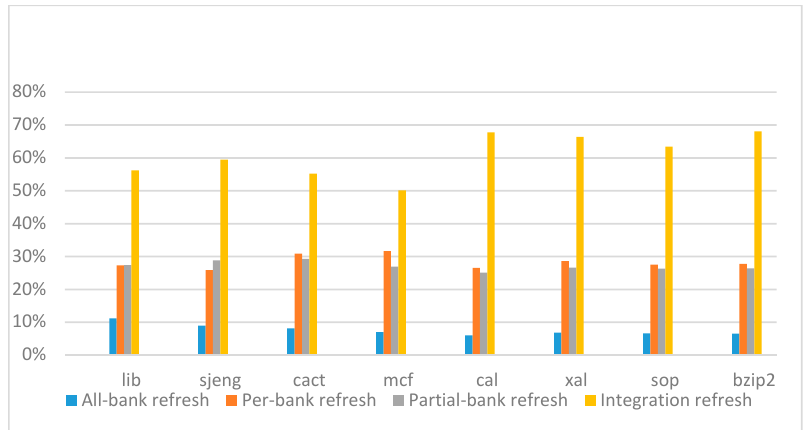
Figure 29. Energy reduction normalized to 1x granularity baseline (tRFC = 890 ns, weak row = 5%).